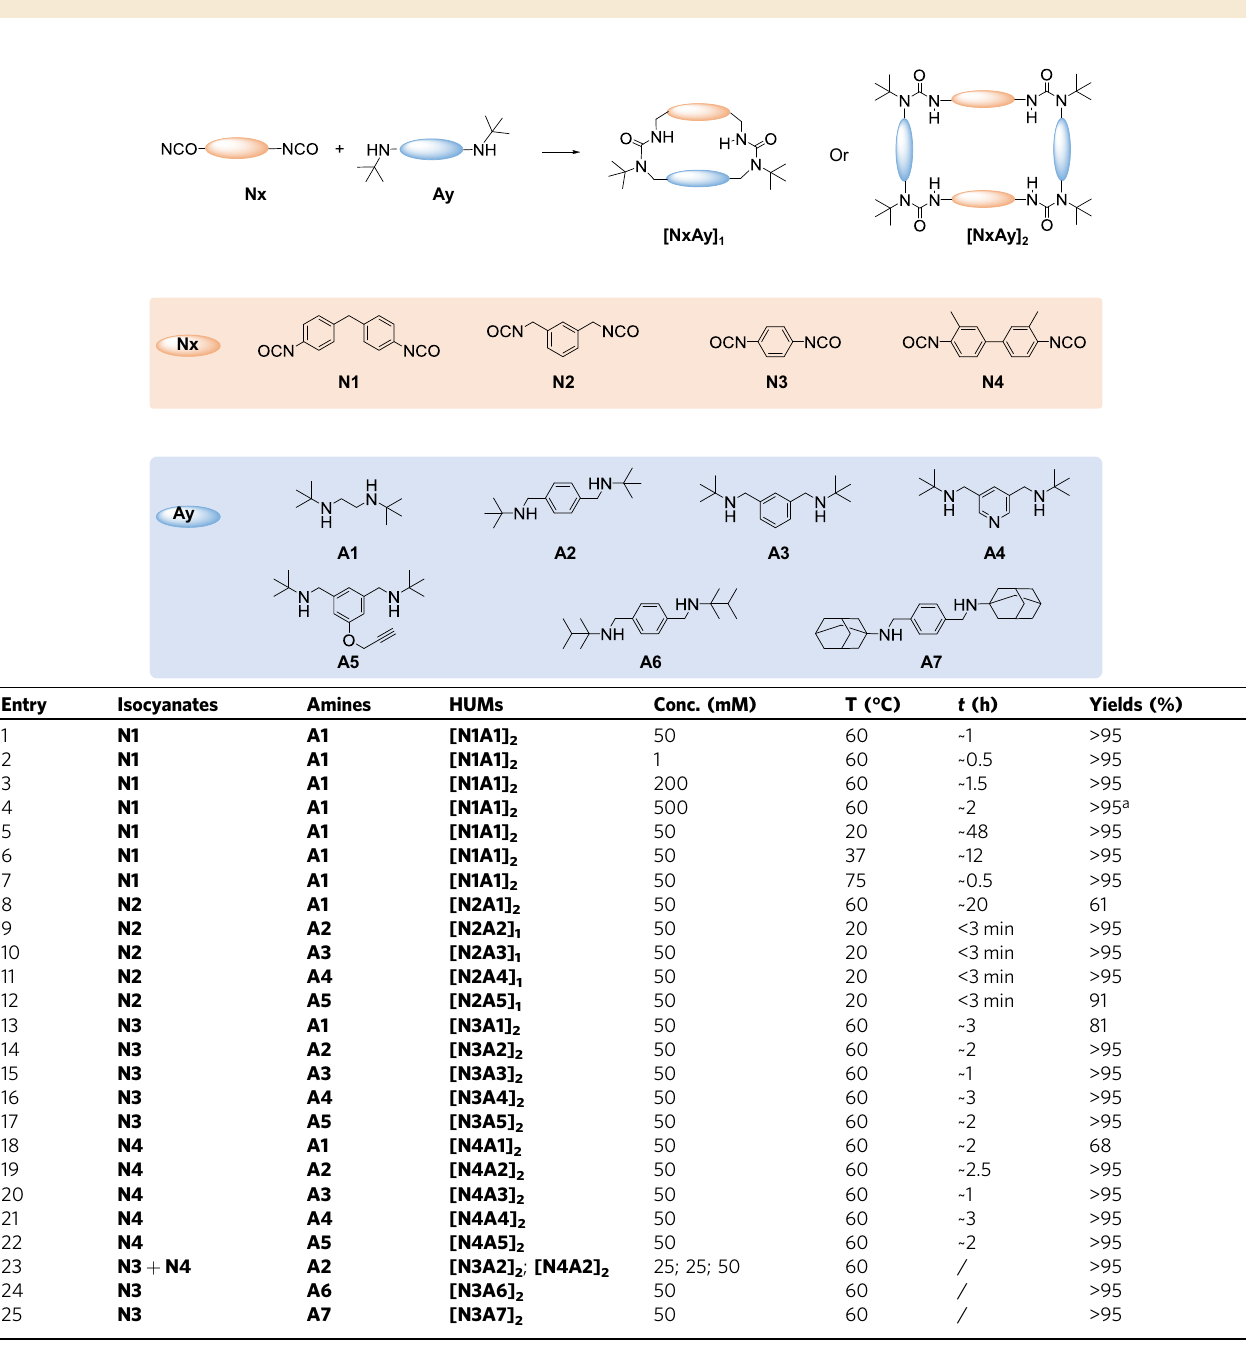
Upper: Schematic illustration for the formation of monomeric macrocycles [NxAy] 1 or dimeric macrocycles [NxAy] 2 from the combination of diisocyanates Nx and hindered diamines Ay, and the corresponding structures of Nx and Ay ( x = 1 – 4, y = 1 – 7). Orange: diisocyanates; blue: hindered diamines. Bottom: Yields of HUMs for different representative combinations under different conditions. Yields were determined by 1 H NMR. a Product precipitated out as white crystals because of limited solubility of the